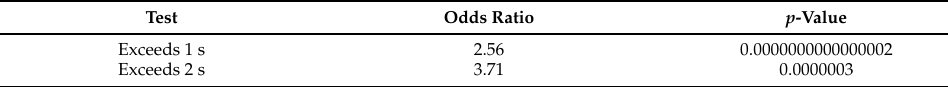
Table 18. Dependence check: ST exceeds N seconds.